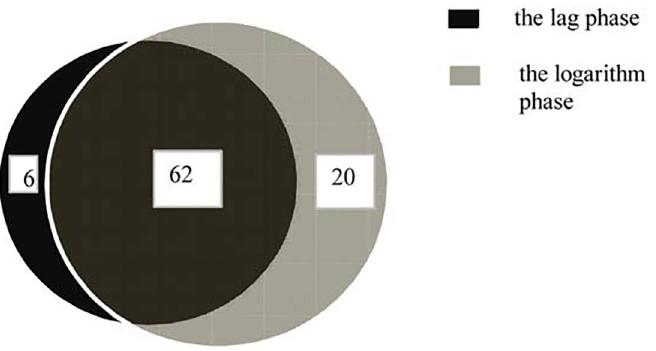
Fig 2. Venn diagram of identified known miRNAs in the two libraries. The diagram not only shows the numbers of miRNA that were expressed in the lag phase and the logarithmic phase preferentially but also the co-expressed miRNAs in both